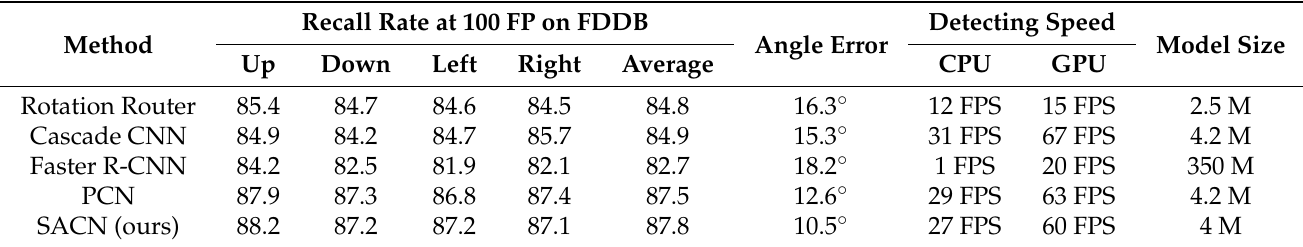
Table 1. Performance comparisons with other methods.